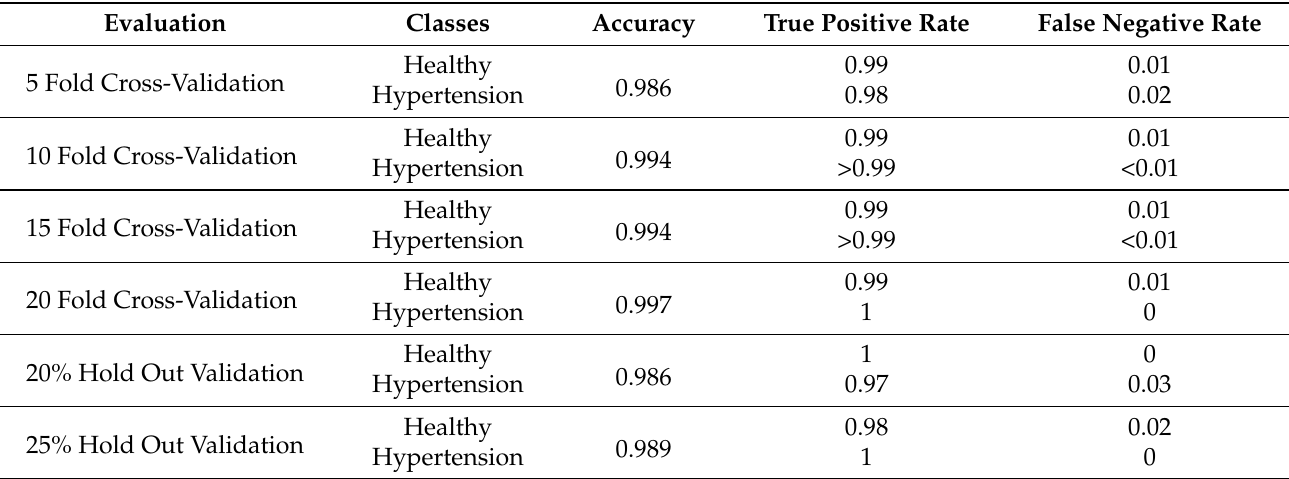
Table 14. Validation of the selected scheme of method